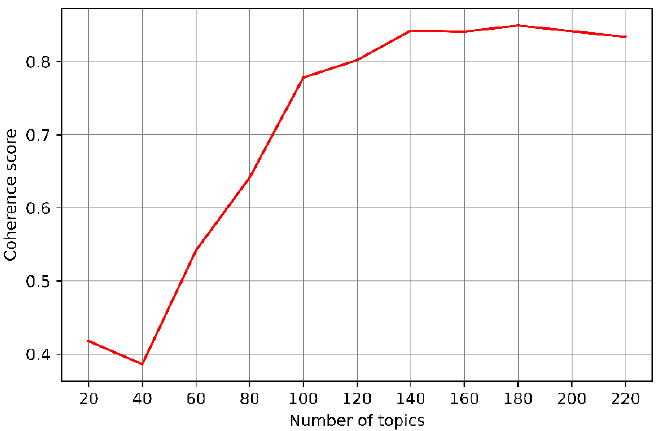
Figure 3. Change in coherence score over the number of topics for the Choi dataset.